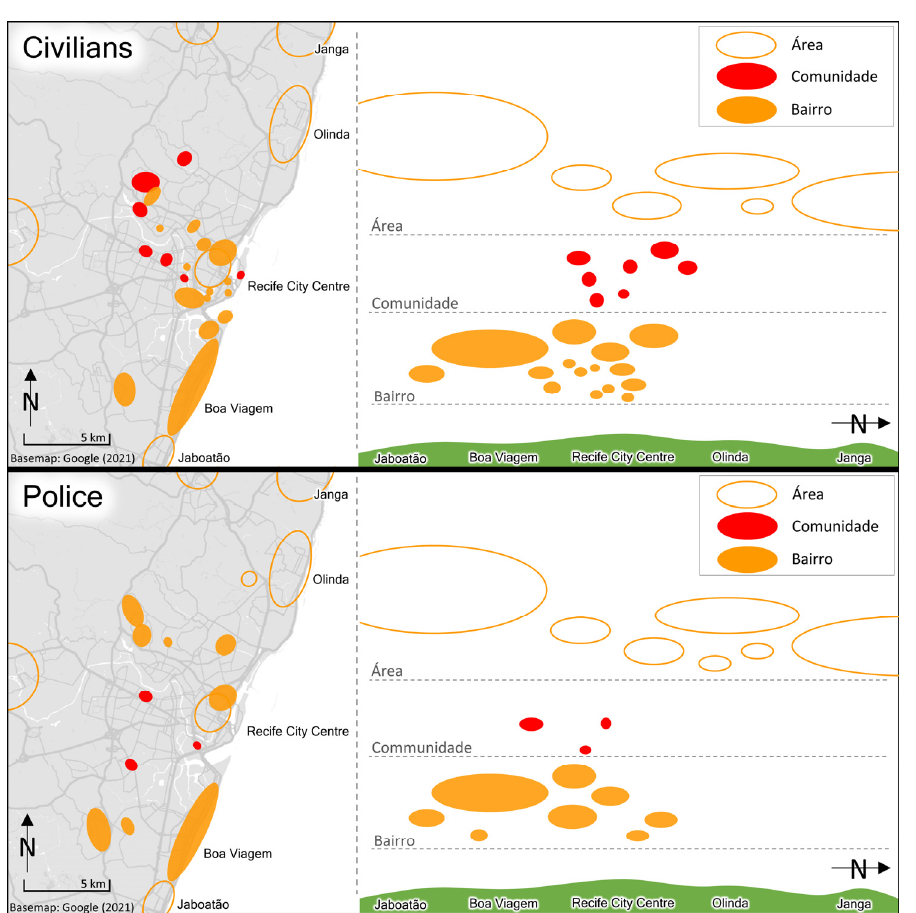
Figure 3. Hierarchies of placial references in interviews with civilians and police, prior to being shown the map in Figure